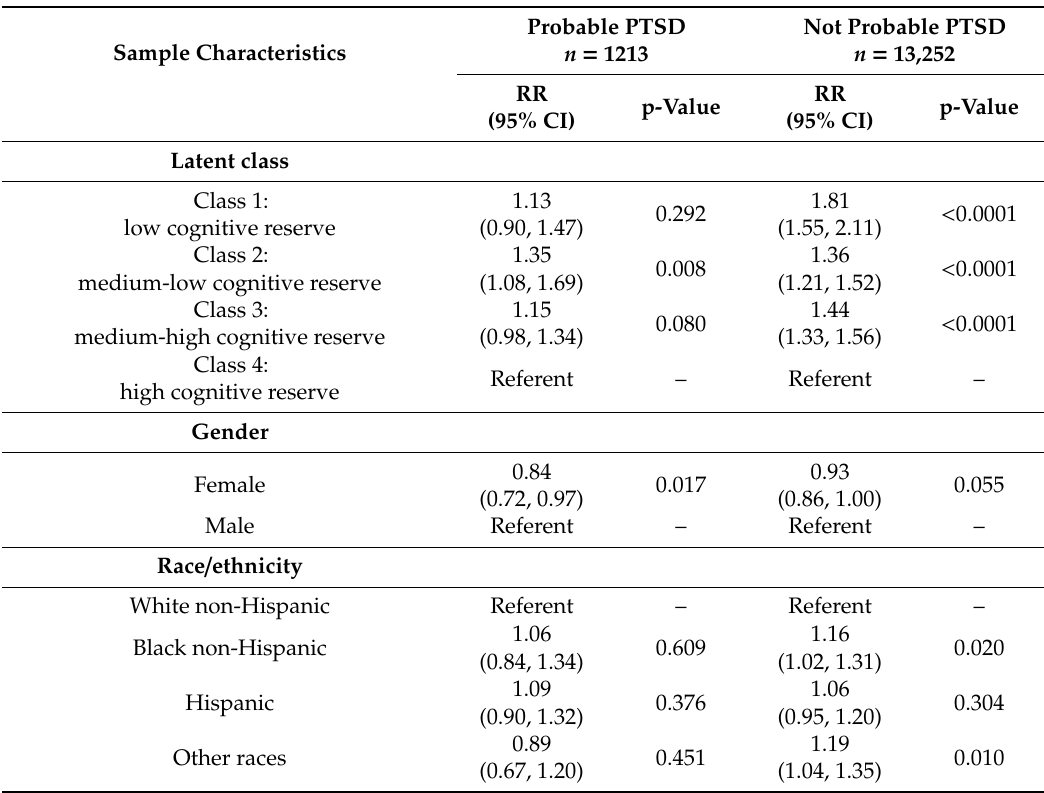
Table 3. Adjusted log binomial model to predict confusion or memory loss by probable PTSD status. Sample